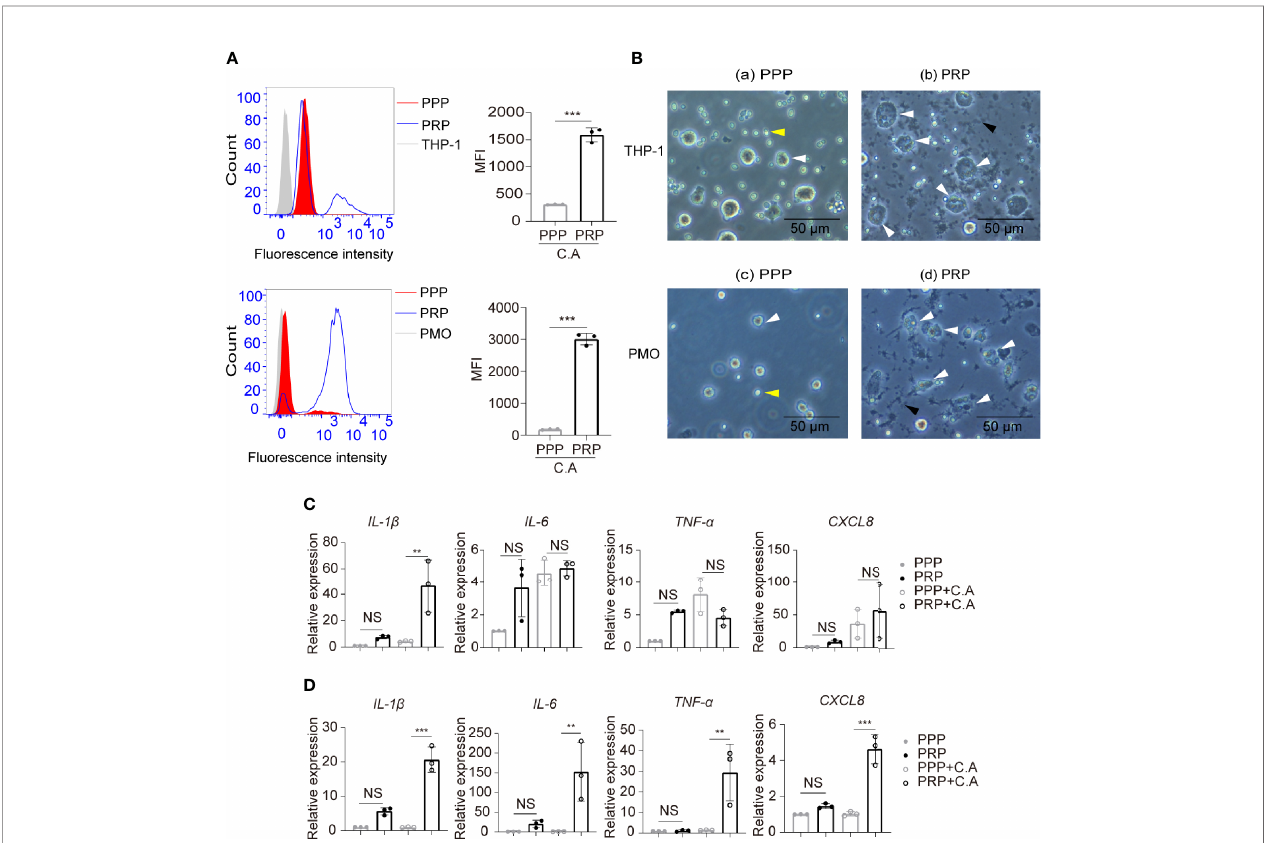
FIGURE 4 | Platelets enhance human monocyte phagocytosis and expression of in fl ammatory cytokines. THP-1 monocytes or primary human monocytes were incubated with the fl uorescent dye FUN-1-labeled C. albicans in the presence of PRP or PPP at 37°C for 2 h (3:1, fungi to monocytes; 50:1, platelets to monocytes). (A) Phagocytosis of FUN-1-labeled C. albicans by THP-1 cells (top column) or primary human monocytes (bottom column) was analyzed by fl ow cytometry. Untreated THP-1 cells or primary human monocytes were used as a negative control. (B) Representative images of THP-1cells (a, b) or primary human monocytes (c, d) phagocytosing C. albicans . White arrows, monocytes or monocytes with intracellular C. albicans . Black arrows, platelet aggregation. Yellow arrows, C. albicans . (C, D) mRNA expression of the in fl ammatory cytokines IL-1 b , IL-6 , TNF- a and CXCL8 by THP-1 cells (C) or primary human monocytes (D) treated or untreated with C. albicans in the presence of PRP or PPP at 37°C for 2h. ** P < 0.01, *** P < 0.001 compared with the control by Student ’ s t test (A) or one-way ANOVA followed by Bonferroni ’ s post hoc test (C, D) . C.A, C. albicans ; NS, not signi fi cant; PMO, primary human